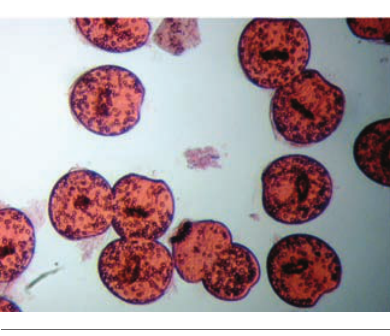
Figure 2. Dead protoscolices after expo- sure to Zingiber officinale extract and staining with 0.1%